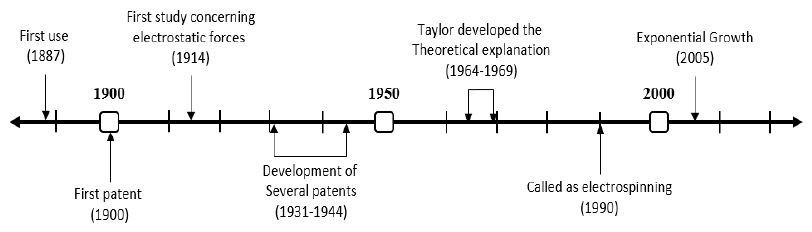
Figure 2. Timeline of the evolution of “electrospinning” over history.